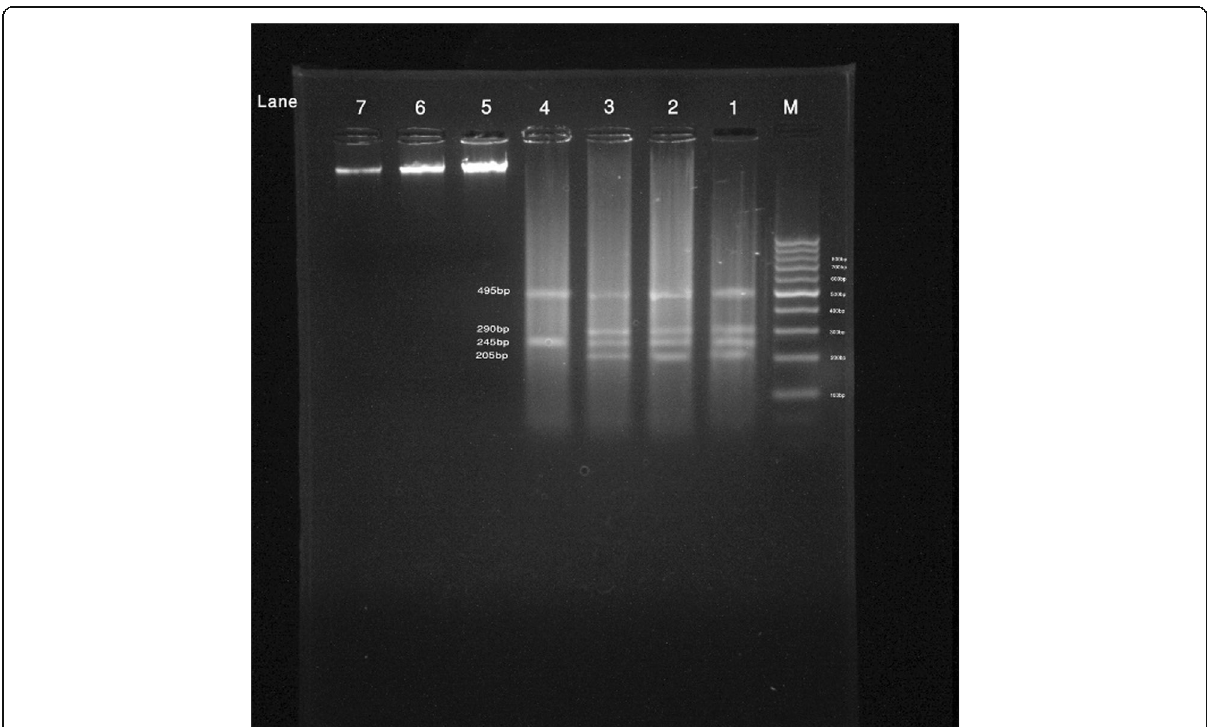
Fig. 4 Representative gel picture showing the PCR-RFLP analysis of TaqI VDR gene polymorphism on ethidium bromide-stained 2% agarose gel. M, marker (100 bp DNA ladder); lanes 1, 2, and 3 represent heterozygous polymorphism (GA genotype; 495, 290, 245, and 205 bp bands); lane 4 represents no polymorphism (AA genotype; 495 and 245 bp bands)